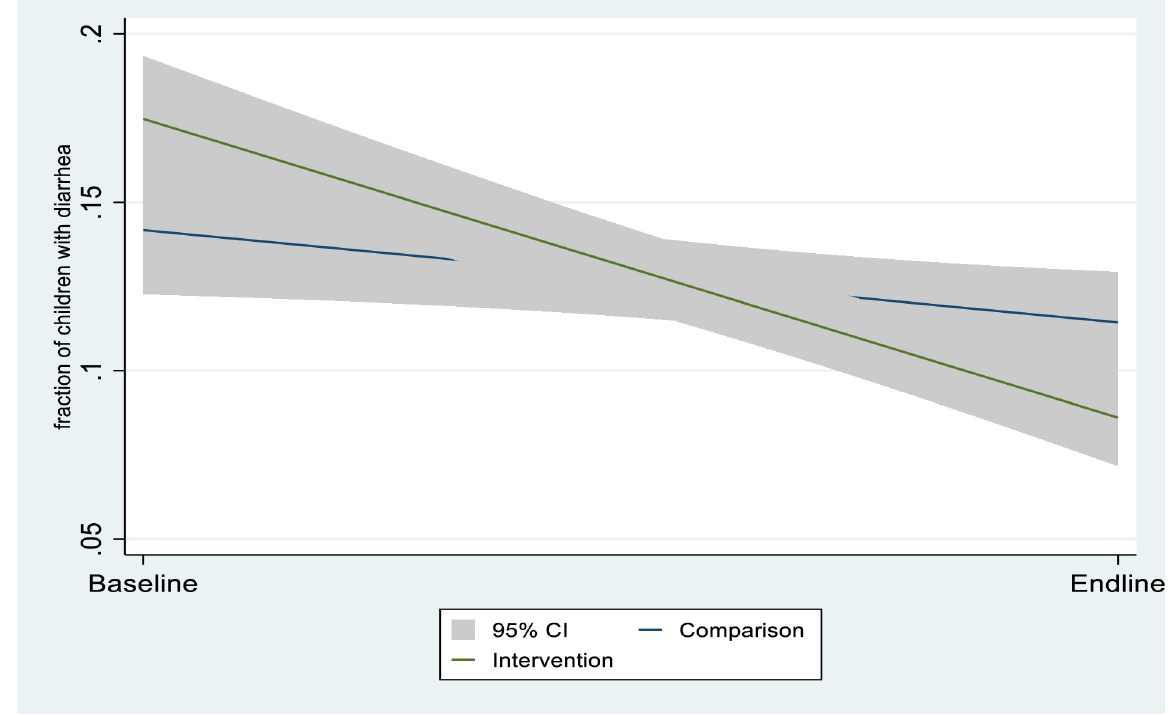
Fig 2. The effect of GEHIP on the incidence of childhood diarrhea, according to maternal recall.